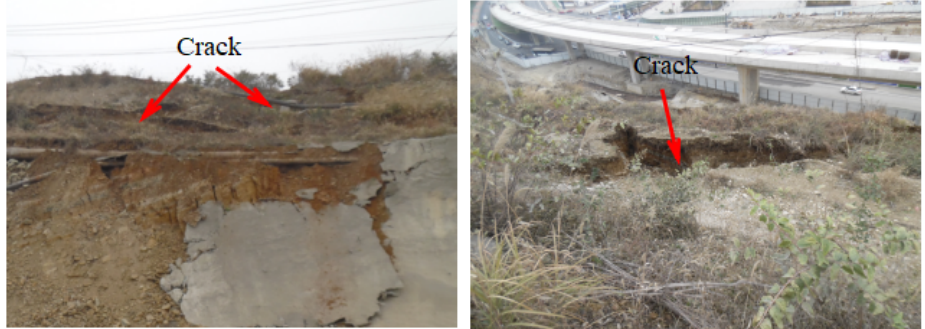
Figure 1. Drilling TV results ( engineering geology of soft